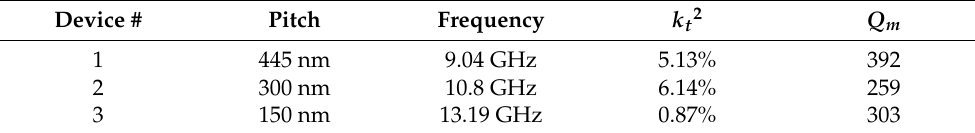
Table 1. Summary of the three CLMRs reported in Figure 8.